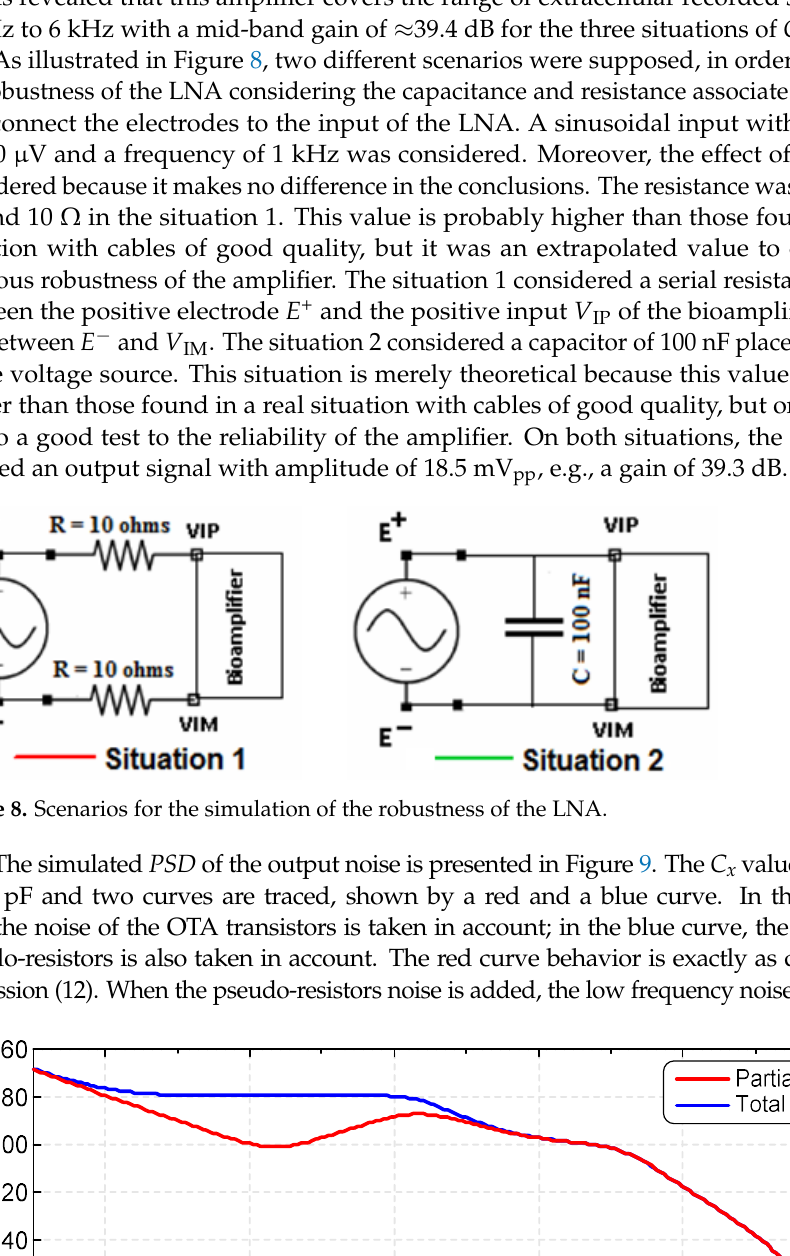
Figure 7. Simulated frequency response of the LNA for C x = 0 ( red trace ), C x = 3.9 pF ( blue trace ), and C x = 9.2 pF ( green trace ).